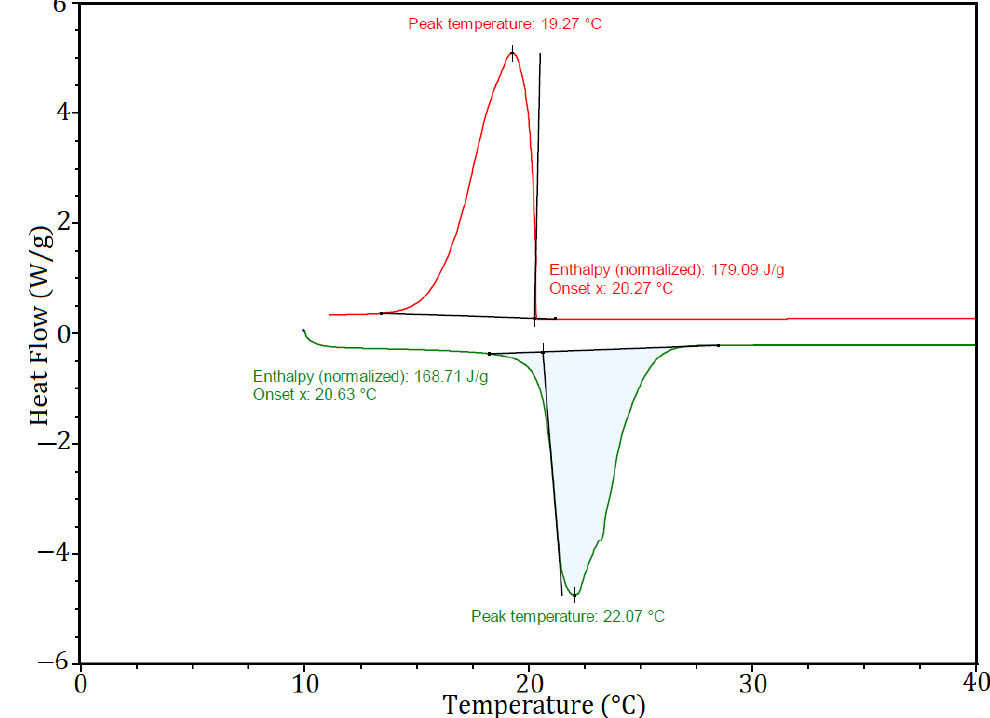
Figure 2. Melting (green) and solidifying (red) DSC curves of the PCM (nHD).